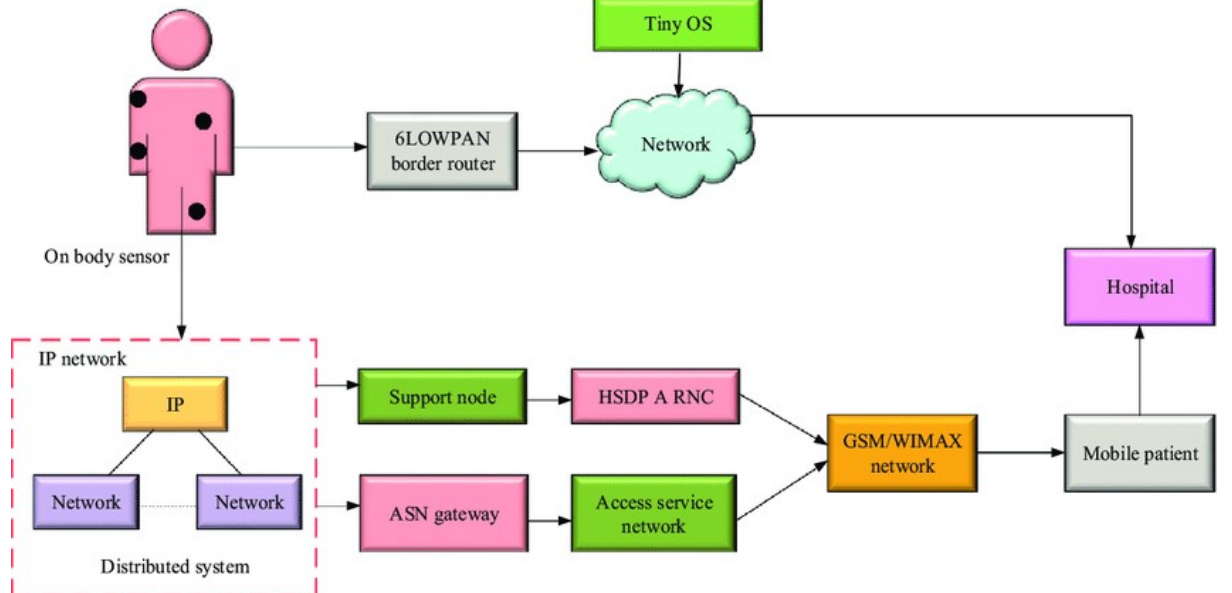
Figure 3. The "dimension-subset-attribute" framework of the cardiac emergency information space. OS: overall survival, IP: intraperitoneal, ASN: asparagine, GSM: Global System for Mobile